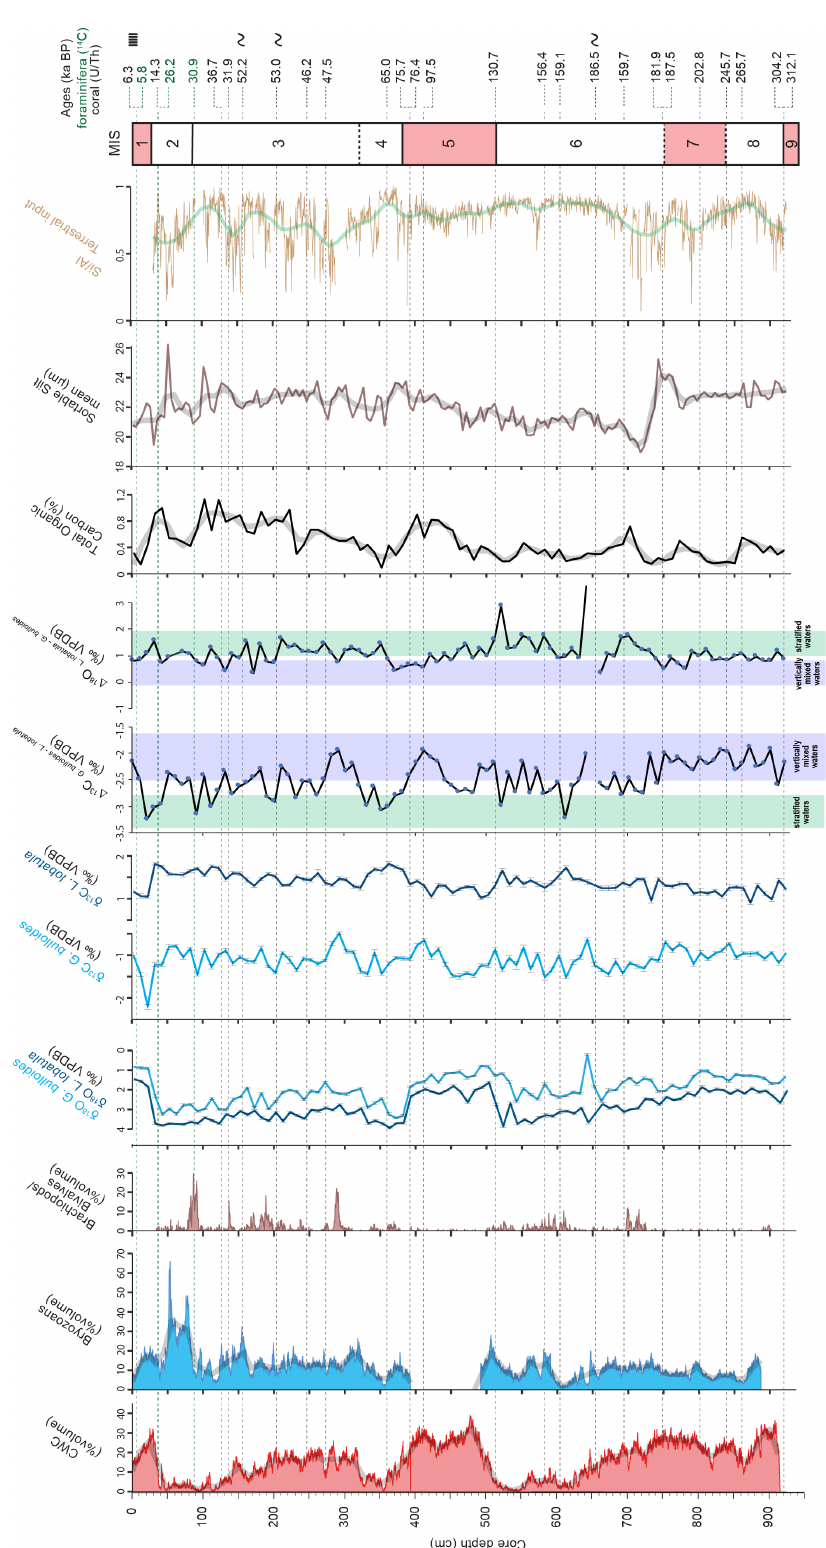
Figure 5. Planktonic ( G. bulloides ) and benthic ( L. lobatula ) δ 13 C records, (cid:49) 13 C ( δ 13 C G. bulloides – δ 13 C L. lobatula ) and (cid:49) 18 O ( δ 18 O L. lobatula – δ 18 O G. bulloides ) records, total organic carbon content (%), mean grain size of the sortable silt fraction (the 10–63µm grain size range, expressed inµm; McCave et al., 2006), and the log 10 silica (Si) aluminium (Al) normalized ratio. Smoothed curves are indicated by the shaded curves. The planktonic ( G. bulloides ) and benthic ( L. lobatula ) δ 18 O records (‰VPDB) are provided as supporting information. Clim. Past, 18, 1915–1945, 2022